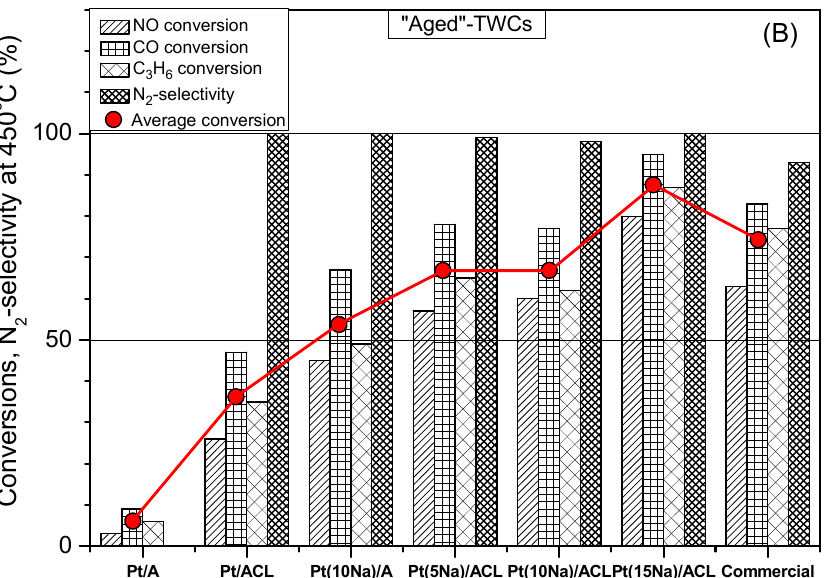
Figure 16. Three-way catalytic performance at 450 ◦ C of “fresh” ( A ) and “aged” ( B ) TWC samples at simulated stoichiometric gasoline engines exhaust conditions (0.1% NO + 0.7% CO + 0.1067% C 3 H 6 + 0.78% O 2 , balanced with He at 1 bar; F t = 3200 cm 3 (STP)/min). (Reproduced with permission from Ref. [98]; Copyright 2011, Elsevier).